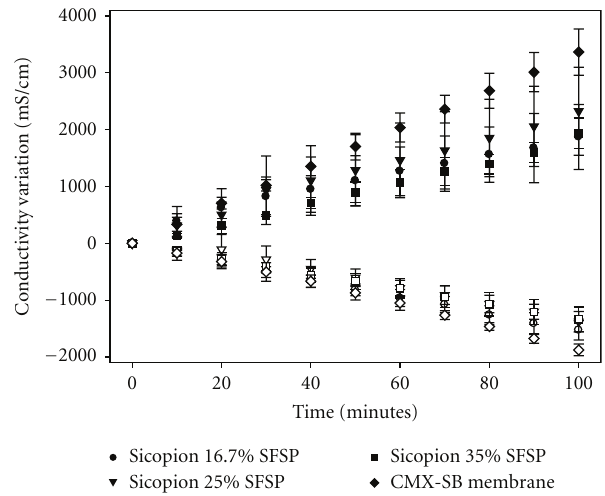
Figure 10: Evolution of pH in the concentrate and diluate solutions (solid and empty symbols, resp.) during the 100-minute deminer- alization procedure. Membranes specified in the legend indicate the CEM defining the diluate compartment.